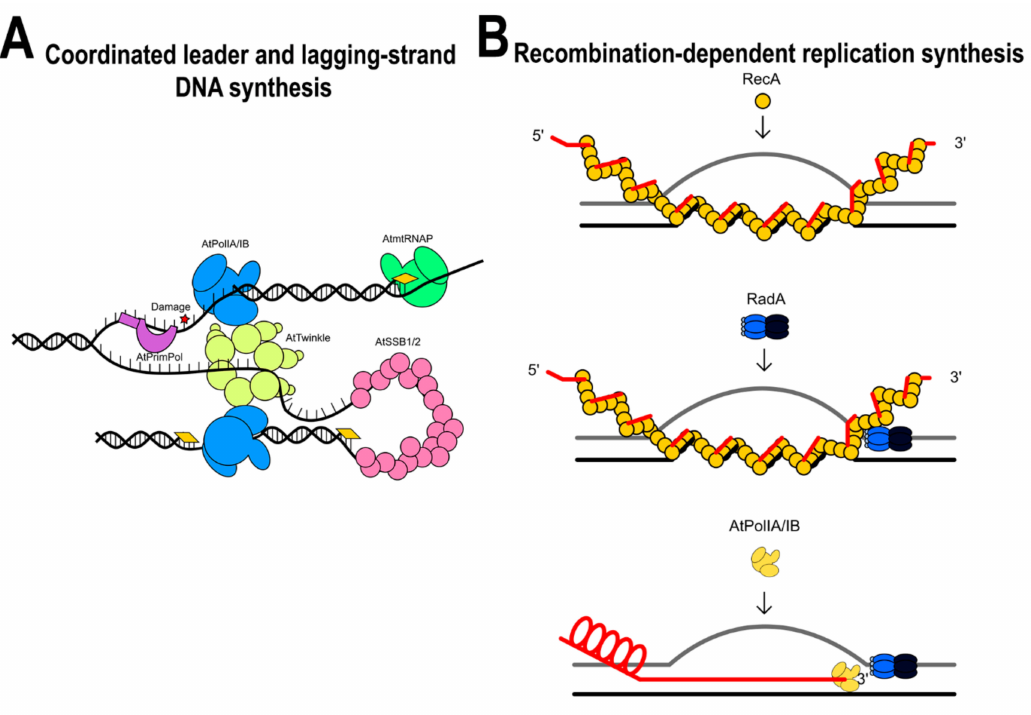
Figure 14. Putative models for DNA replication in plant mitochondria. ( A ) Leader and lagging-strand DNA synthesis. ( B ) Recombination-dependent replication systems in plant